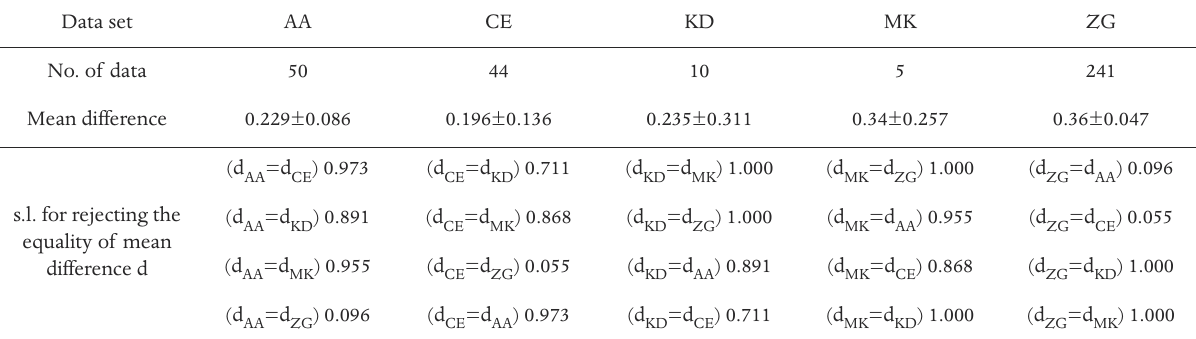
Table 4. As Table 1 for mean differences of the M